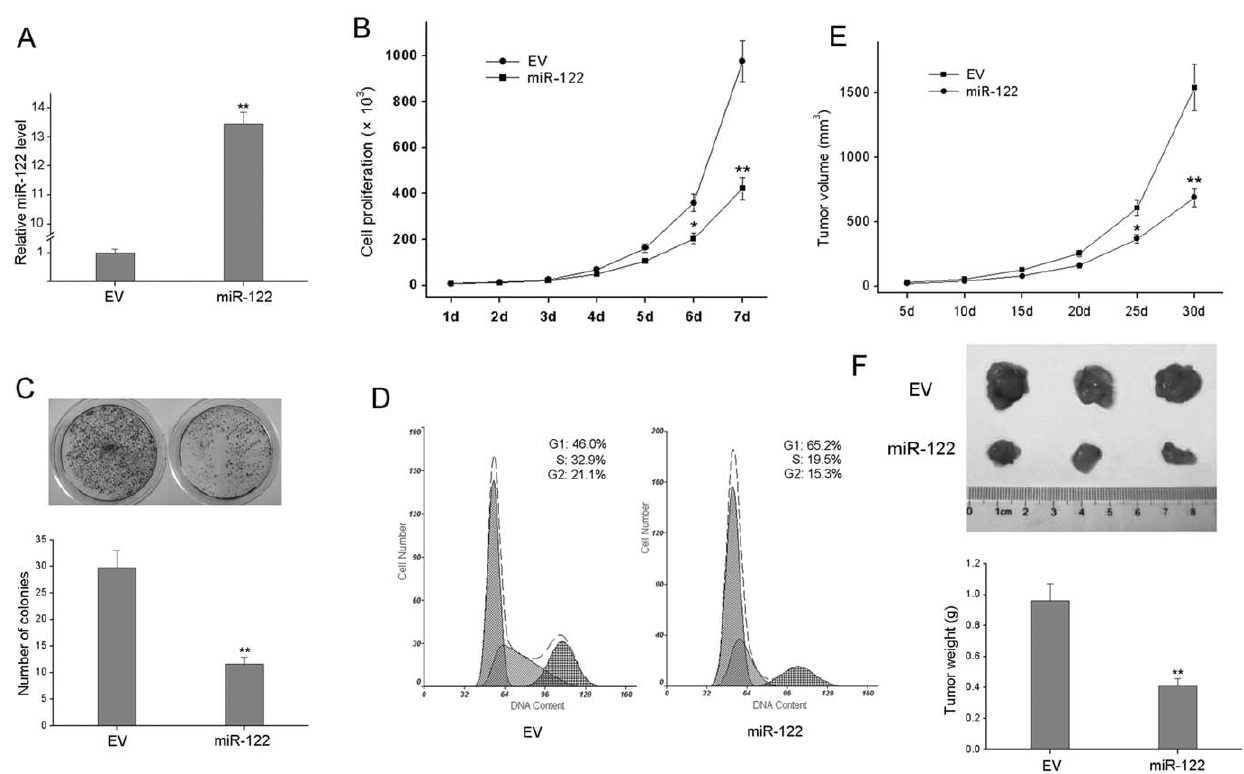
Figure 2. Overexpression of miR-122 suppresses cell proliferation of MCF-7 cells in vitro and in vivo. (A) miR-122 was over-expressed in MCF-7 cells and confirmed by qRT-PCR. (B) Growth curves of miR-122 and EV-infected MCF-7 cells were conducted. (C) Colony formation was assayed in miR-122 and EV-infected cells, and colonies consisting more than 50 cells were counted. (D) Cell cycle progression was assayed using flow cytometric analysis. (E) Tumor size observation in nude mice after the inoculation. The average size of the tumors was measured every 5 days and shown in the curves. (F) Tumor sizes of 3 representative nude mice. The tumor weight was measured. All experiments were carried 3 times independently. *P , 0.05 compared to EV group. **P , 0.01 compared to EV group.